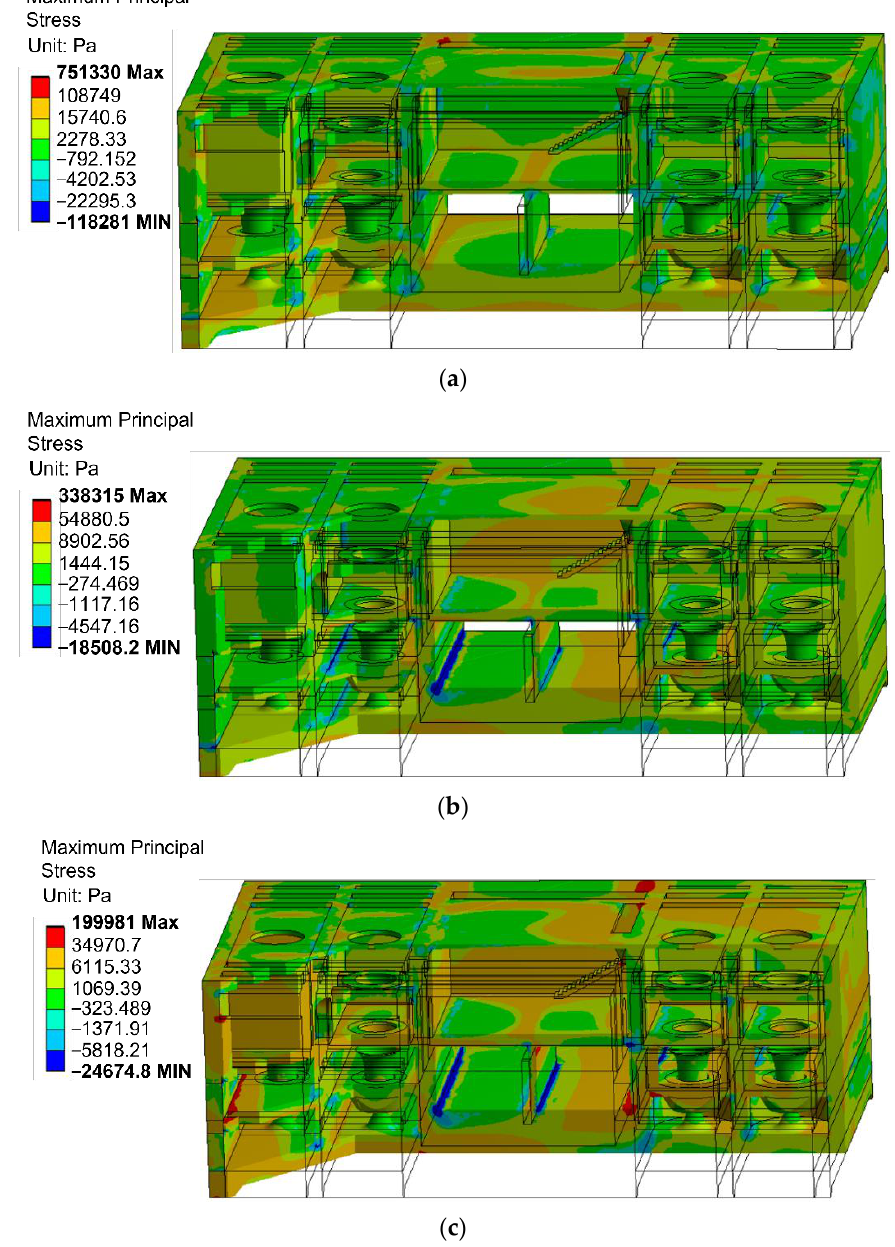
Figure 16. Total dynamic stress of the station building structure under three working conditions: ( a ) drainage condition; ( b ) diversion condition Ⅰ ; ( c ) diversion condition Ⅱ .